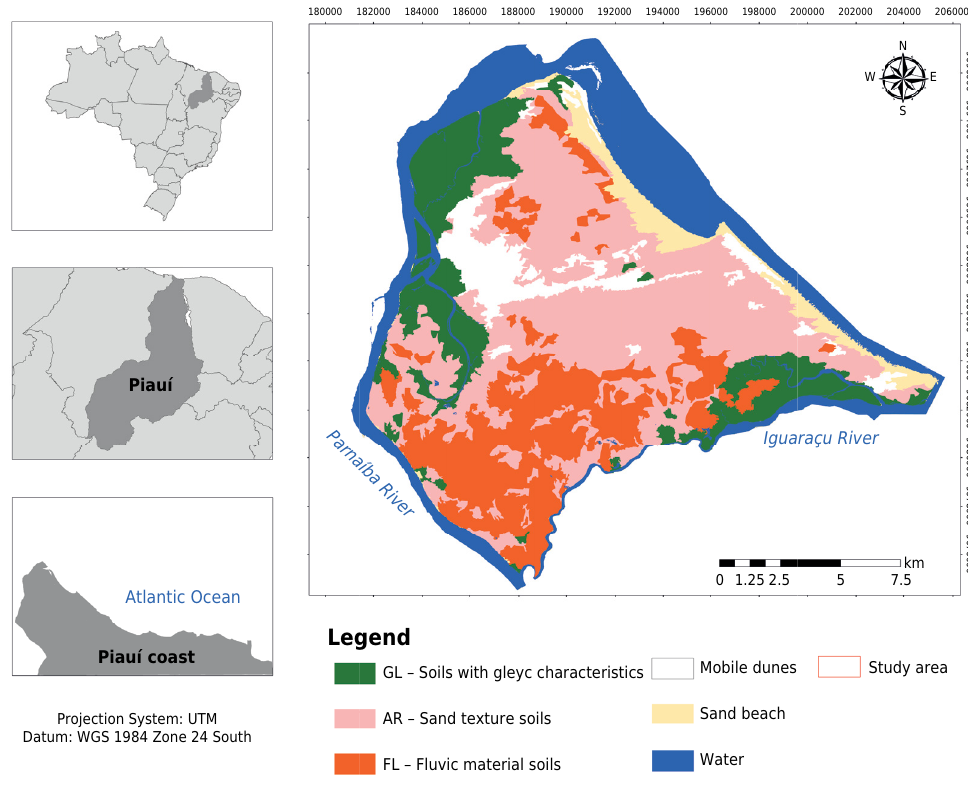
Figure 7. Digital soil mapping generated from the data matrix 2.